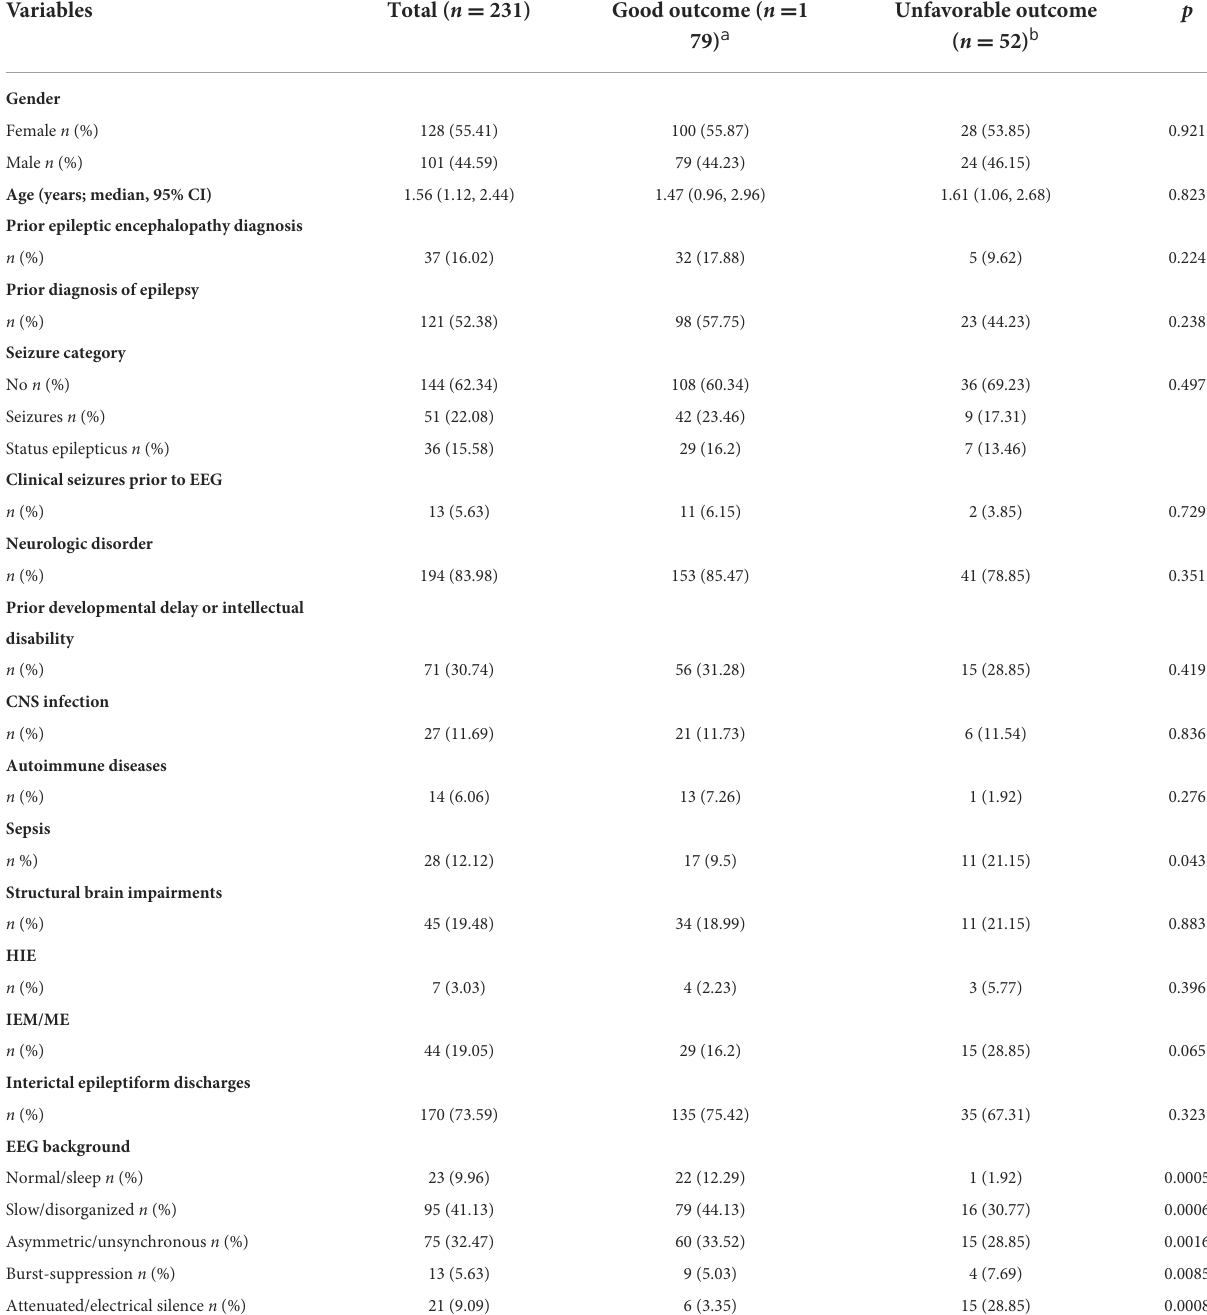
TABLE 5 Association between clinical variables and in-hospital